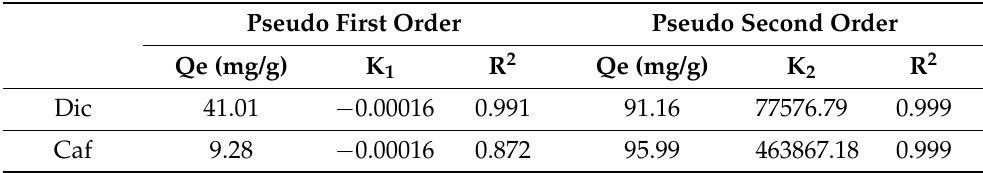
Table 4. Pseudo-first-order and pseudo-second-order parameters for adsorption of Dic and Caf onto AC based on argan nutshells.